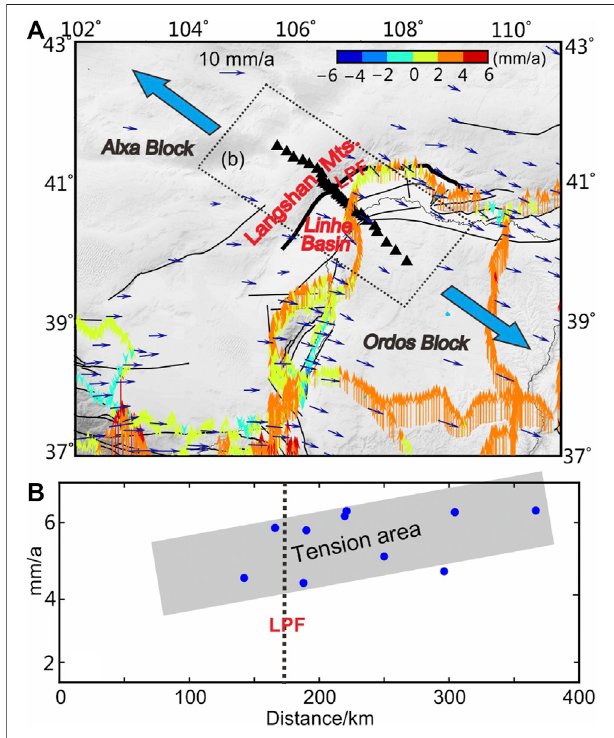
FIGURE 7 | Distribution map of the global positioning system (GPS) velocity fi eld and leveling fi eld in the study area and adjacent areas (A) , and GPS velocity decomposition (B) pro fi le (blue arrow indicates the direction of regional stress fi eld (modi fi ed from Zhang et al., 2006; Cui et al.,